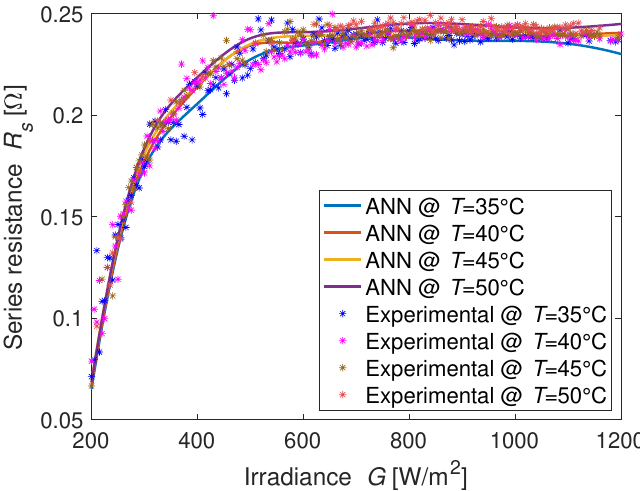
Figure 9. ANN identification of the series resistance in healthy condition.